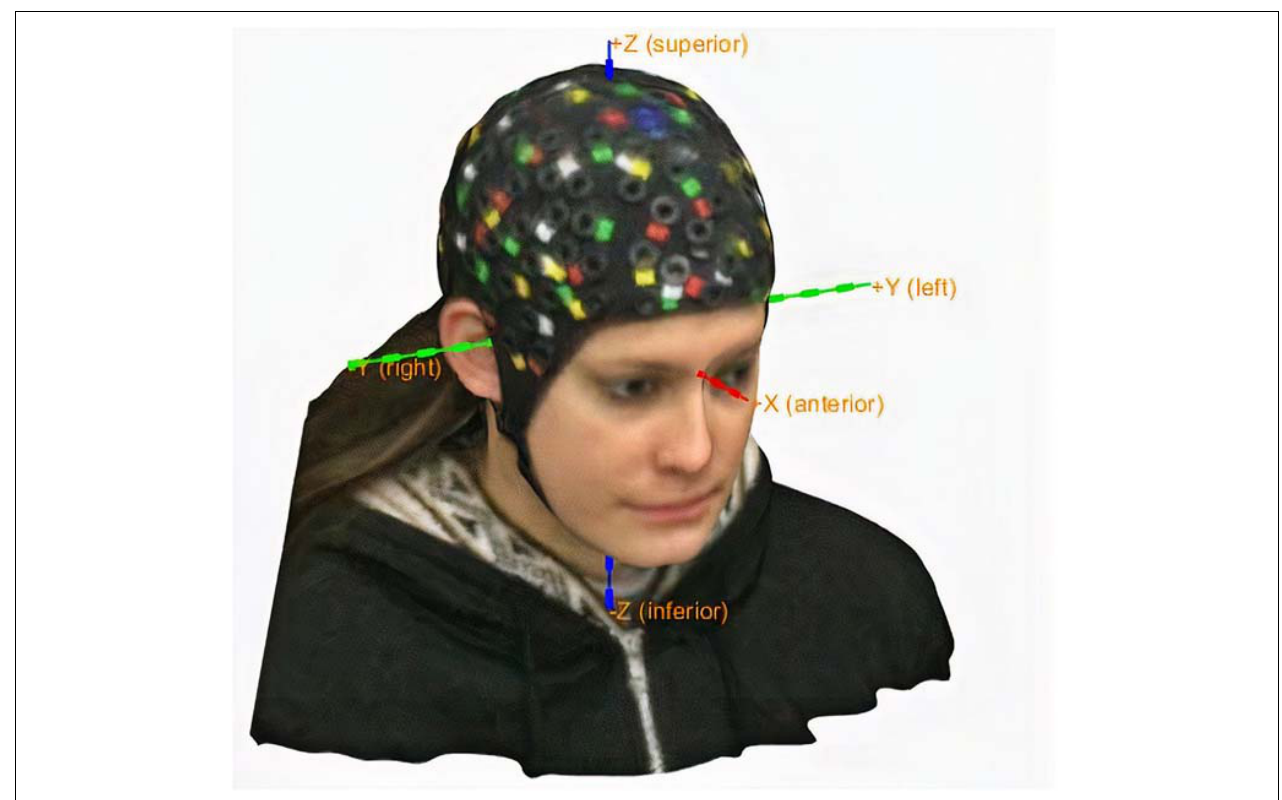
FIGURE 13 | Subject coordinate